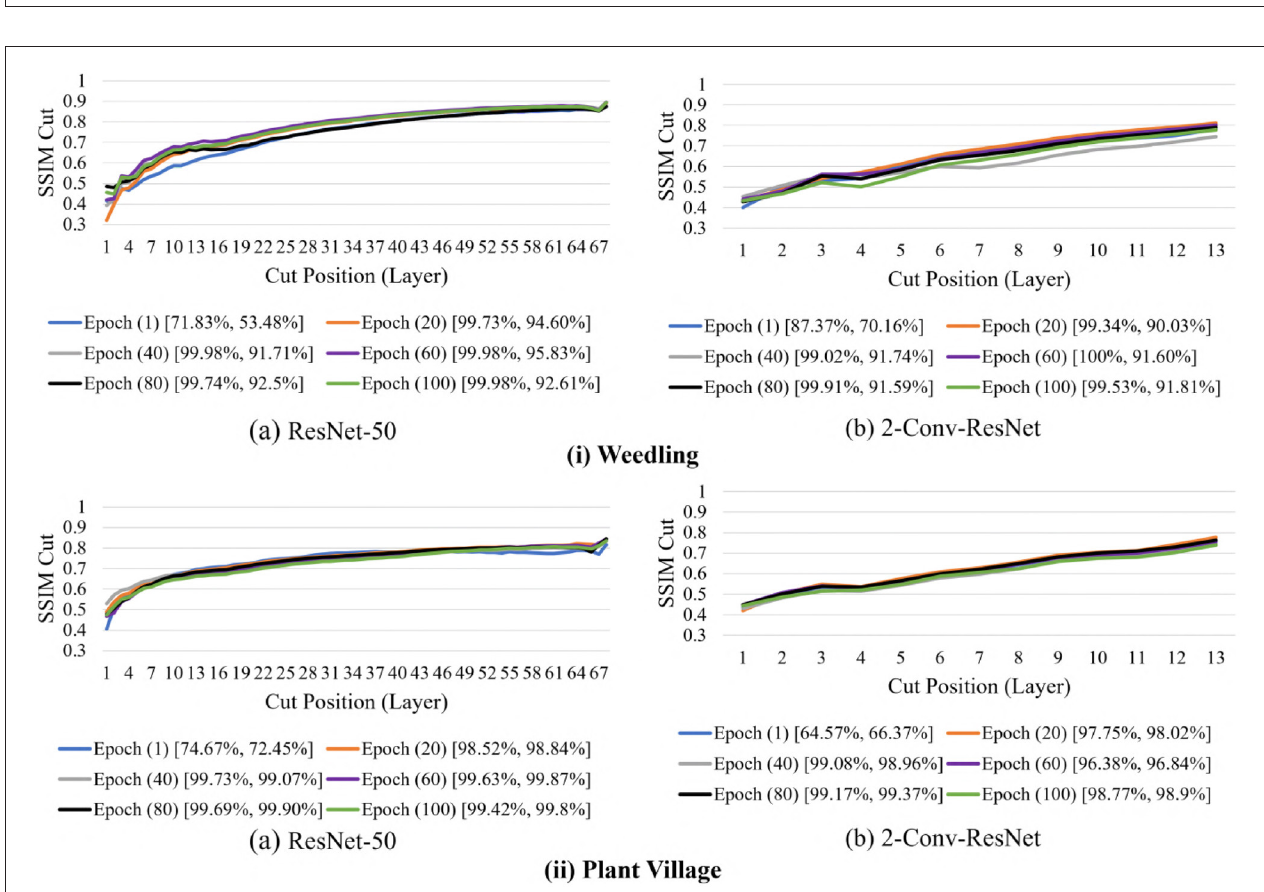
FIGURE 11 | Comparison of the Cut Position (Layer) VS SSIM cut for different epochs of (i) Weedling and (ii) Plant Village dataset using (a) ResNet-50 and (b) 2-Conv-ResNet. The value in the legend of the chart indicate the training and testing accuracy of the model.